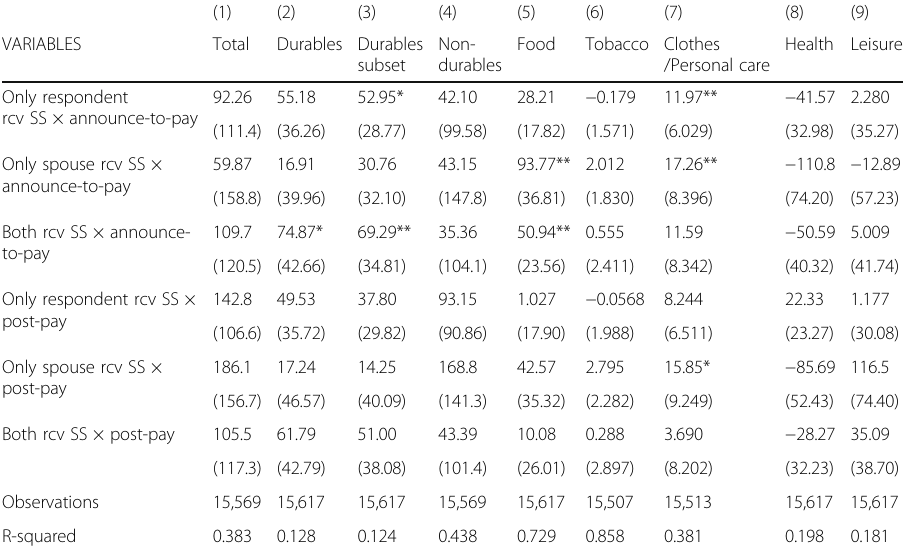
Non- Food Tobacco Clothes Health Leisure subset durables /Personal care 92.26